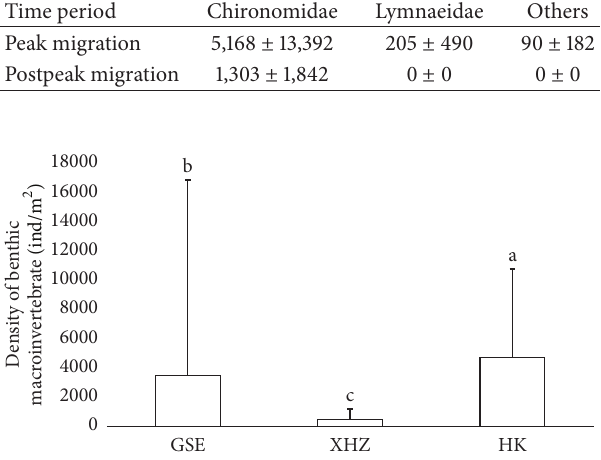
Figure 3: Density of benthic macroinvertebrate (mean ± SD) at the three sampling sites of Gesuer (GSE), Xiaohaizi (XHZ), and Hekou (HK) ( 𝑛 = 30 , 12, and 24 for GSE, XHZ, and HK, respectively).